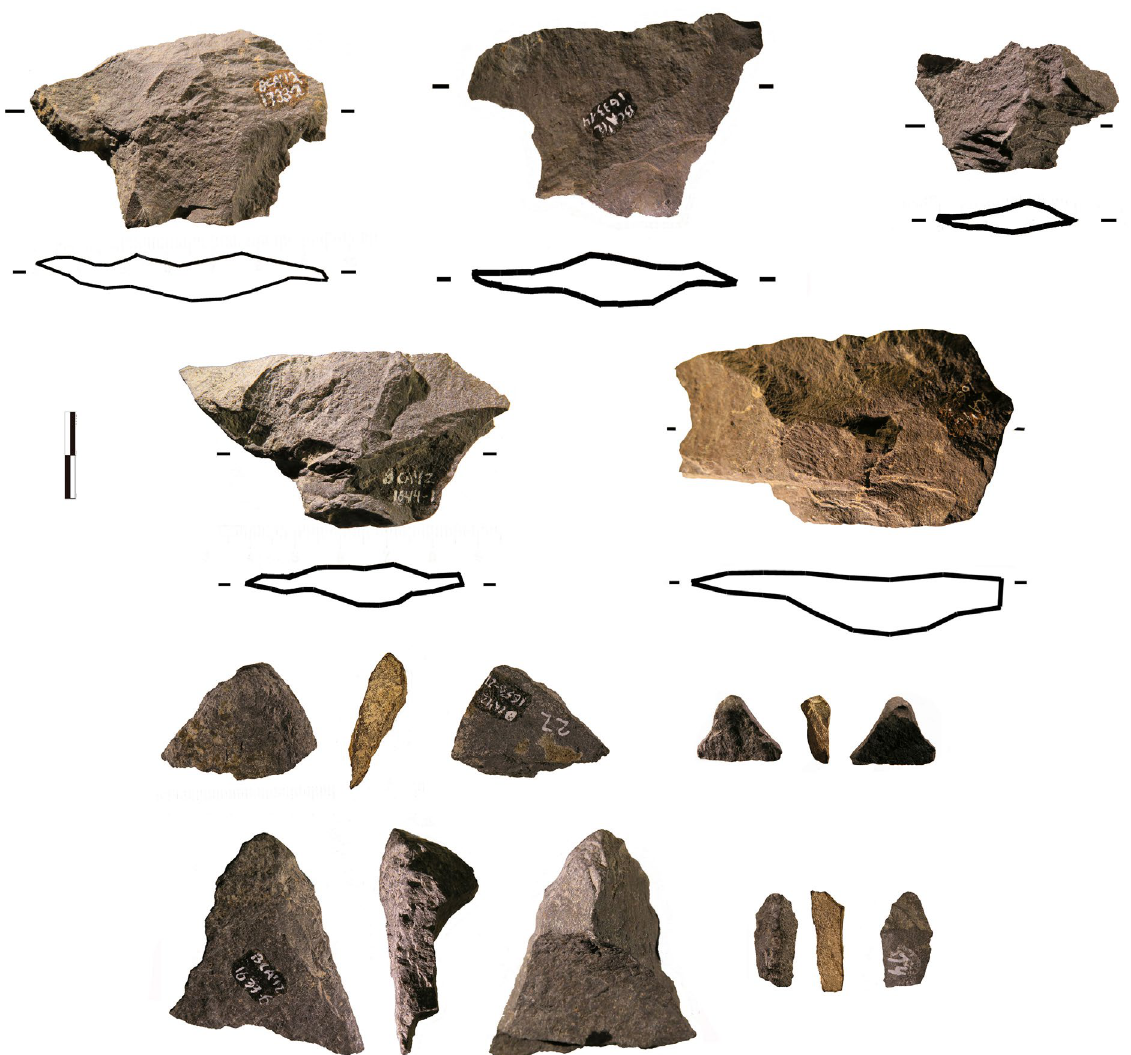
Figure 7. Working debris of the Cardones workshop: a) flakes with narrow bases and b) resharpening flakes of the tip of the picks. The scale bar is 2 cm long (1 cm